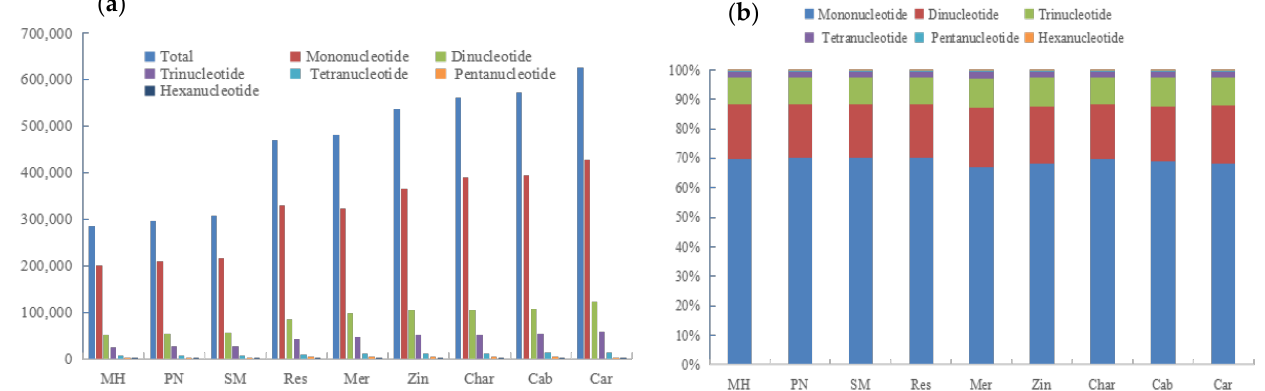
Figure 3. Distribution of SSR motif number ( a ) and proportion ( b ) in genome sequences of different grape varieties. Table 2. Analysis of repeat motif types in grape genome.